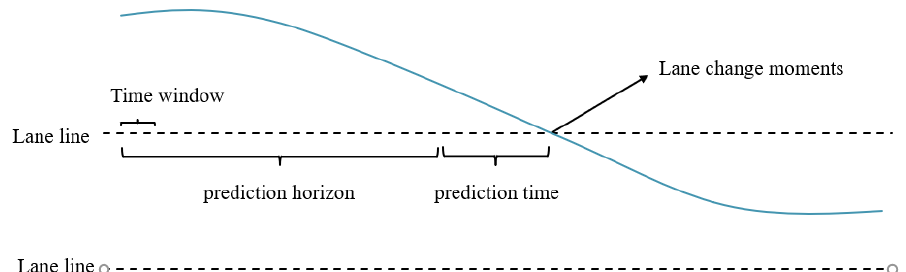
Figure 2. Schematic diagram of time sequence for lane change intention prediction.